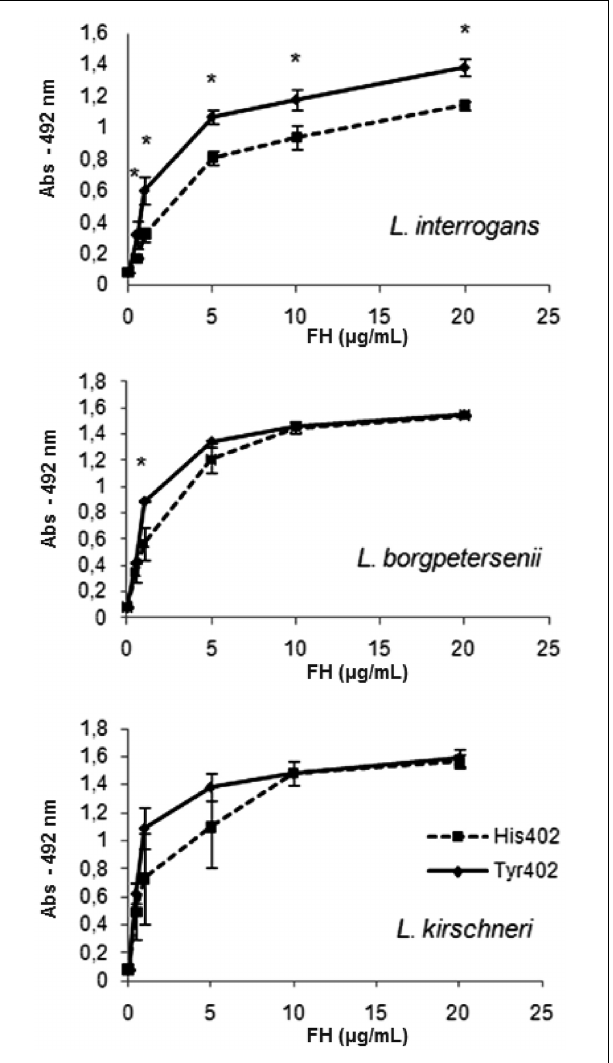
FIGURE 3 | Dose-dependent binding of FH variants to Leptospira. L. borgpetersenii , L. kirshneri , and L. interrogans were incubated with increasing amounts of purified FH His 420 or FHTyr 420 (0–20 μ g/ml) and then immobilized on microtiter wells.The binding was assessed using a polyclonal anti-human FH. Each point represents the mean absorbance value at 492nm ± the SD of three independent experiments. * P ≤ 0.05 (Student’s two-tailed t -test). Both variants of FH were purified only by affinity